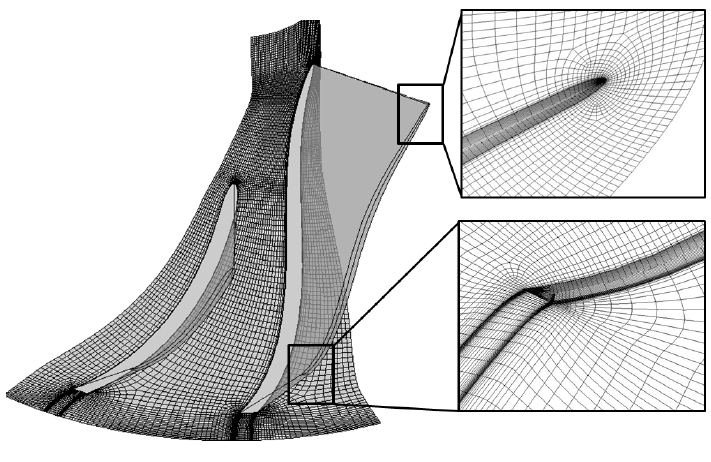
Figure 7. Original impeller grids at hub and